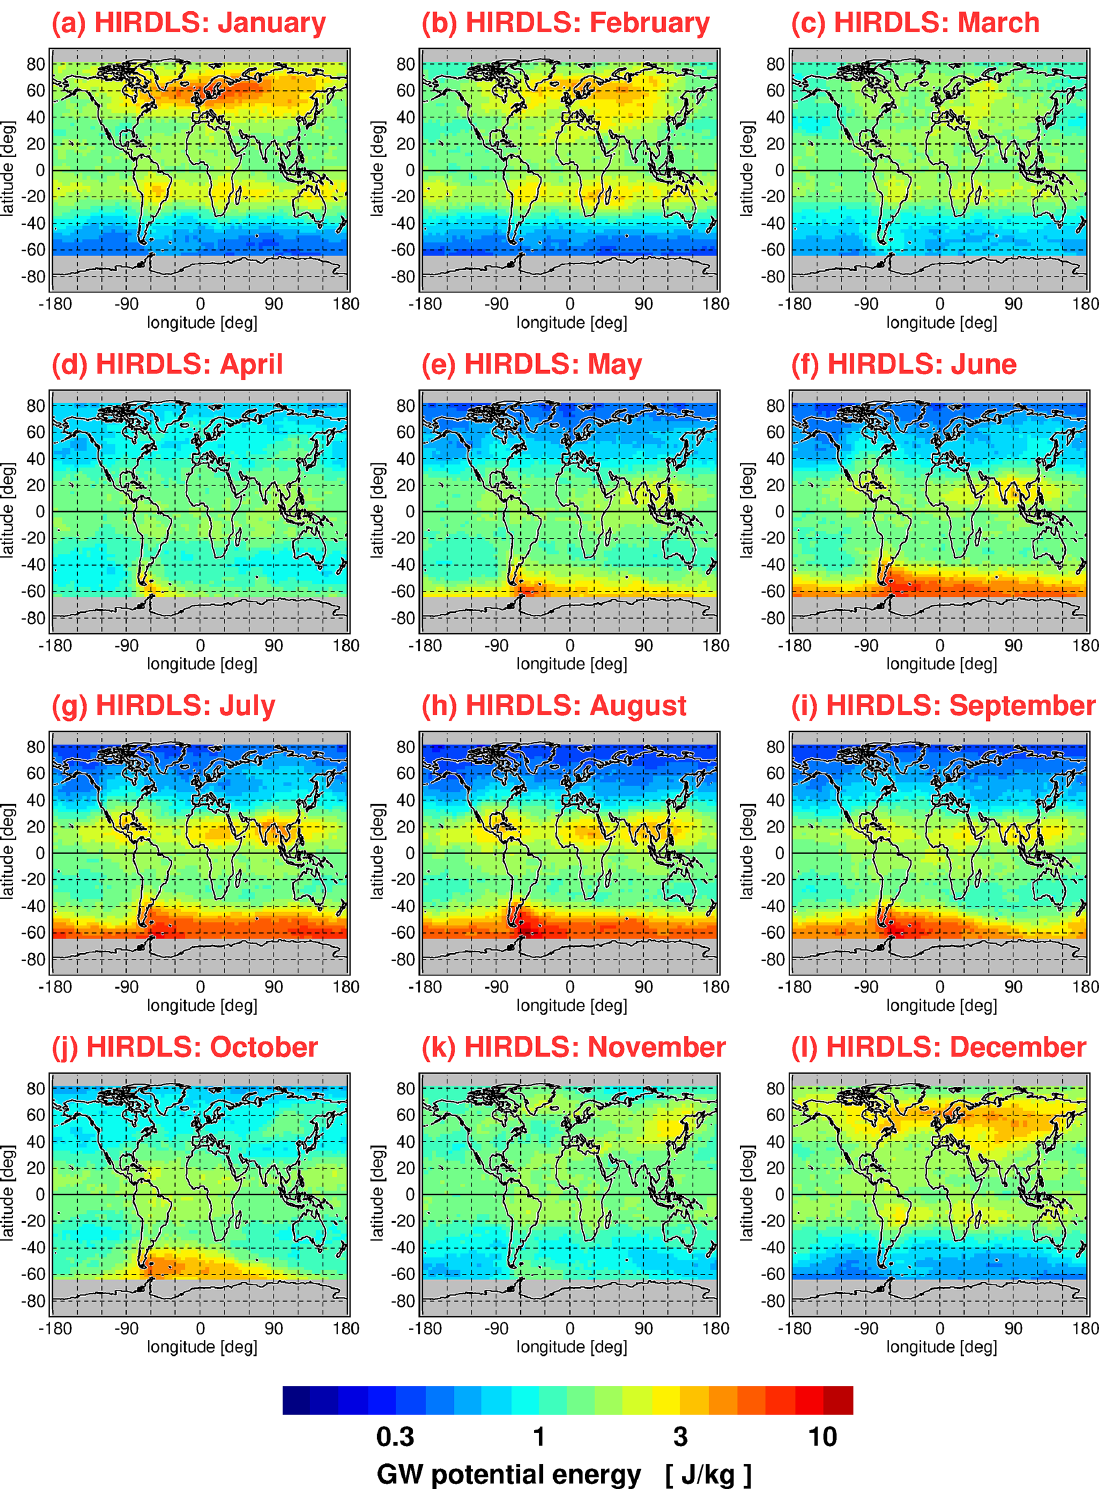
Figure 1. Global distributions of HIRDLS gravity wave (GW) potential energies at 30km altitude for each calendar month. Values shown are multiyear means of monthly median values determined in overlapping 5 ◦ × 15 ◦ (latitude × longitude) grid boxes. The period used for averaging is March 2005 until February